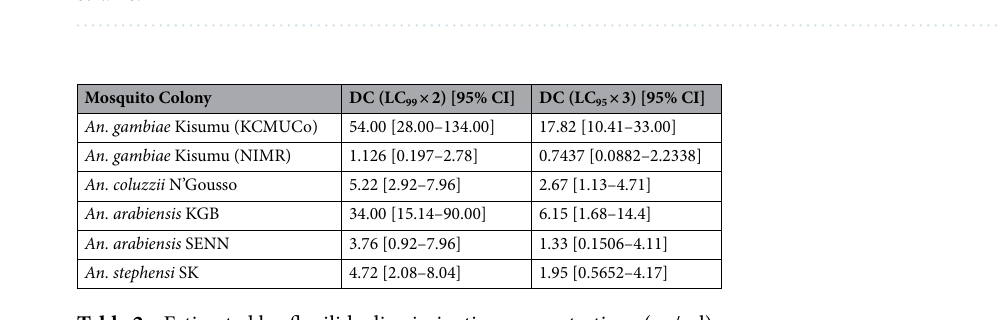
Table 2. Estimated broflanilide discriminating concentrations (μg/ml).